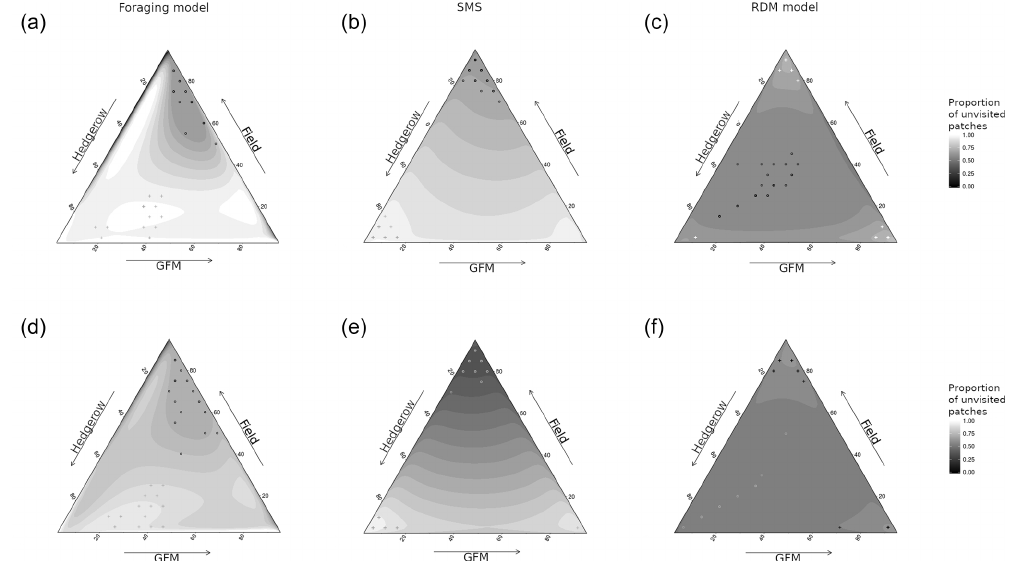
Figure 3. Spatial variation in the field frequentation (proportion of unvisited field pixels) as a function of the model, species sensitivity to habitat, and habitat quality. The sides of the triangle are scaled in percentages of habitat quality of the three habitat types (0–100%). (a, d) Foraging model. (b, e) Stochastic movement simulator. (c, f) Routine and direct movements model. (a–c) Species with high habitat sensitivity during movement. (d–f) Species with low habitat sensitivity. Surfaces are rendered using a cubic interpolation of ternary values. The corresponding actual values are illustrated by circles (lowest 5% of values) and crosses (highest 5% of